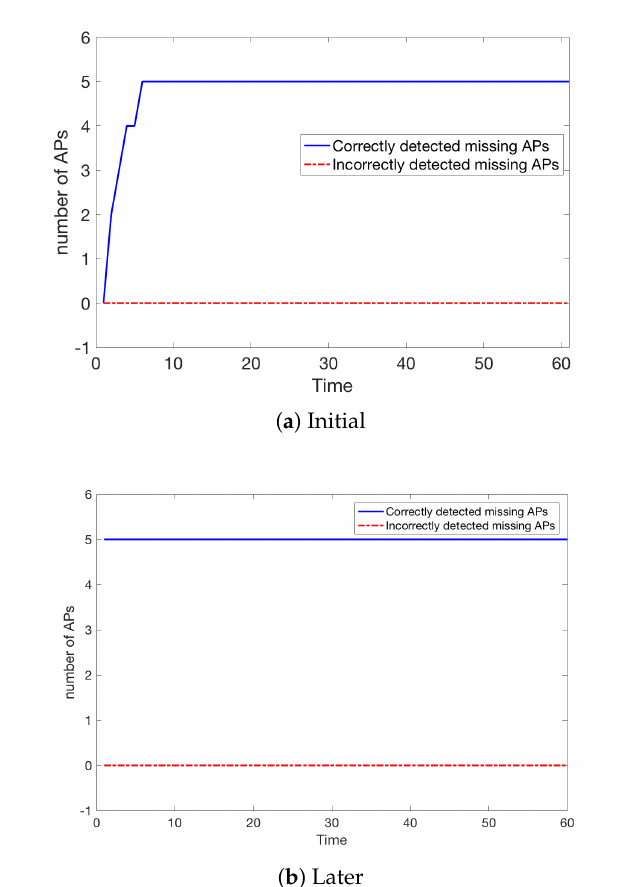
Figure 11. Number of missing APs detected (5 APs are not working).